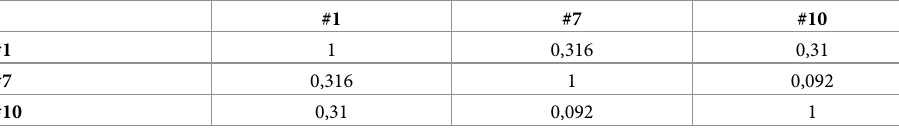
Table 10. Inter-item correlation matrix for subscale 1